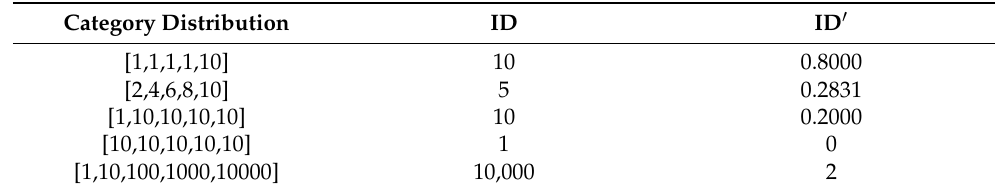
Table 1. Imbalance of different category distributions.